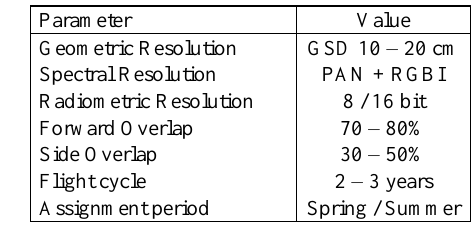
Table 1. Aerial survey parameters of a NMCA